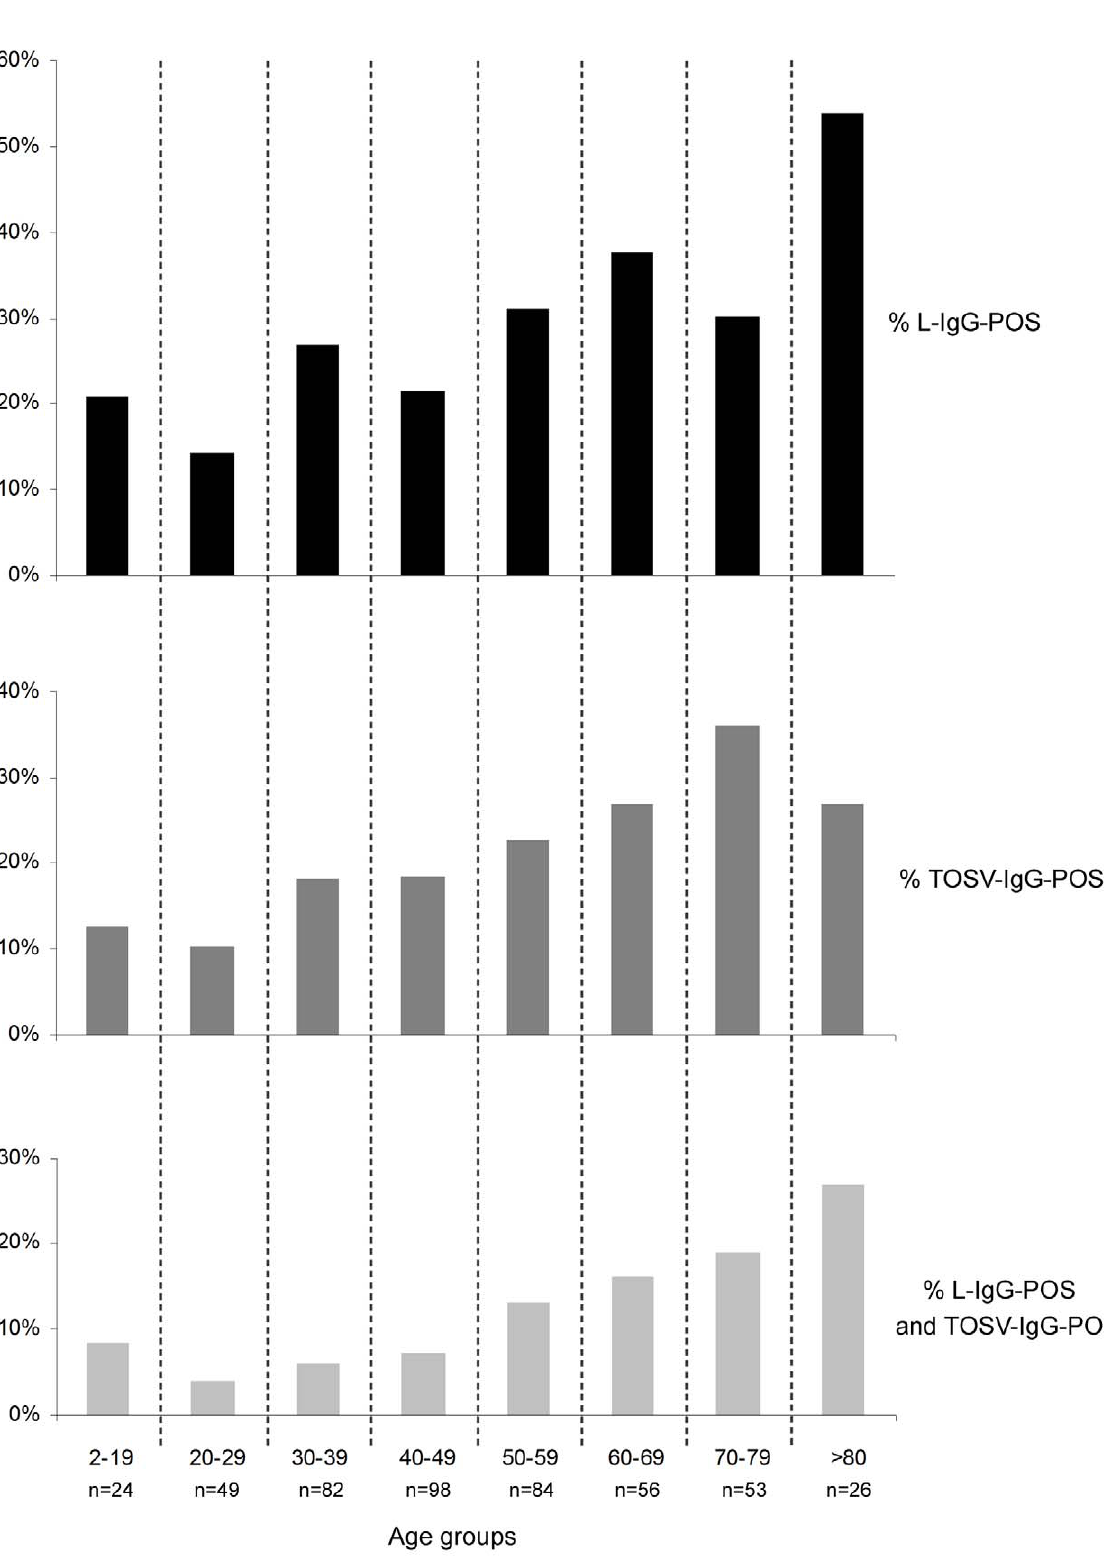
Figure 1. Evolution of Leishmania and TOSV seroprevalence in tested population according to age groups.